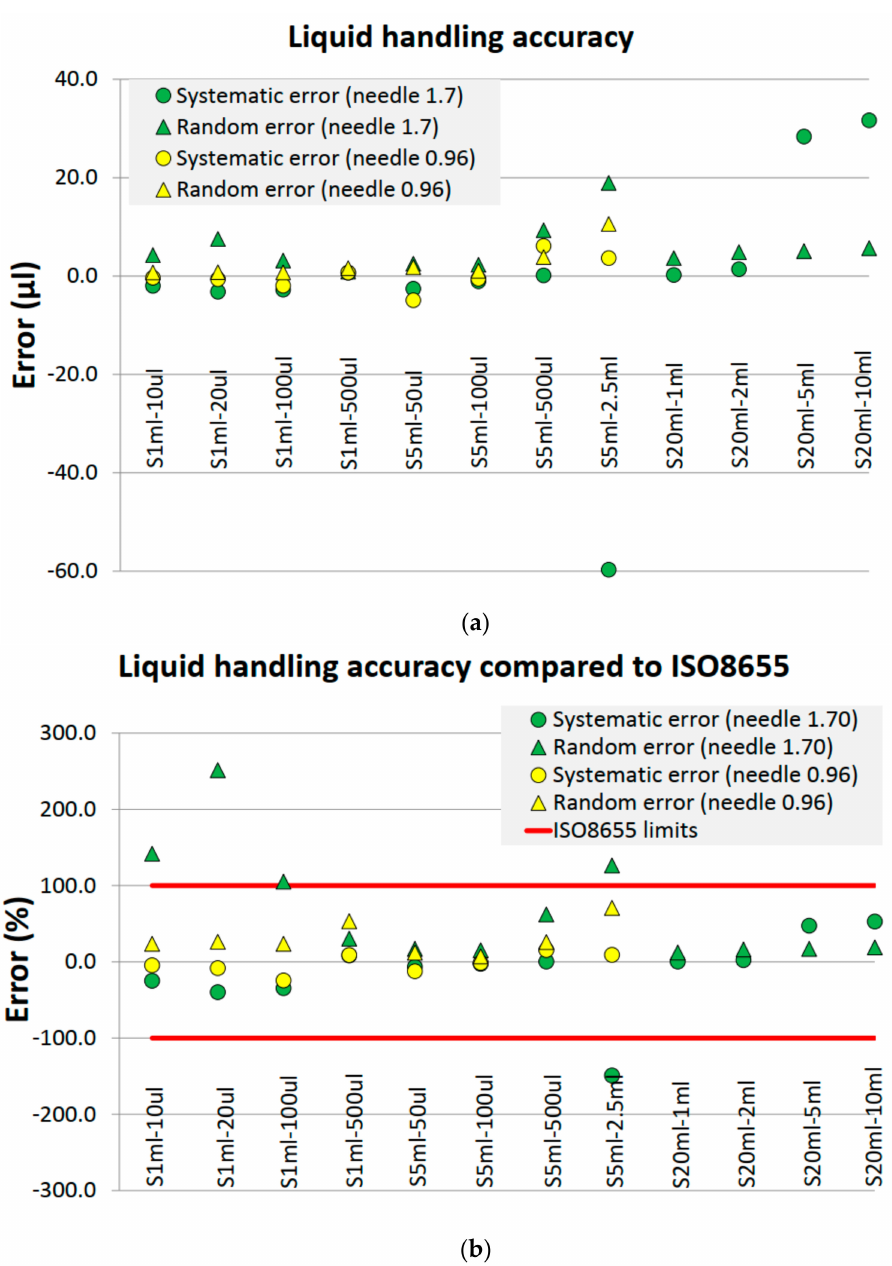
Figure 7. Liquid handling accuracy for the syringe modules in non-contact dispensing. ( a ) The labels specify the syringe size and the dispensed volume for each test, which was run 30 times to find the systematic and random errors in µ L. ( b ) Errors in µ L are normalised using the maximum permissible errors defined by the ISO8655. A test fulfils this standard if the errors are between ± 100%. As the standard states, the maximum permissible errors for the nominal volumes apply to every selectable volume throughout the useful volume range of the piston pipette. Therefore, the maximum systematic and the random errors allowed are ± 8, ± 40, and ± 60 µ L and 3, 15, and 30 µ L for the 1 mL, 5 mL, and 20 mL syringe module, respectively. There are not maximum errors for a 20 mL pipette in the ISO8655. Thus, we have selected the maximum admissible errors for a 10 mL